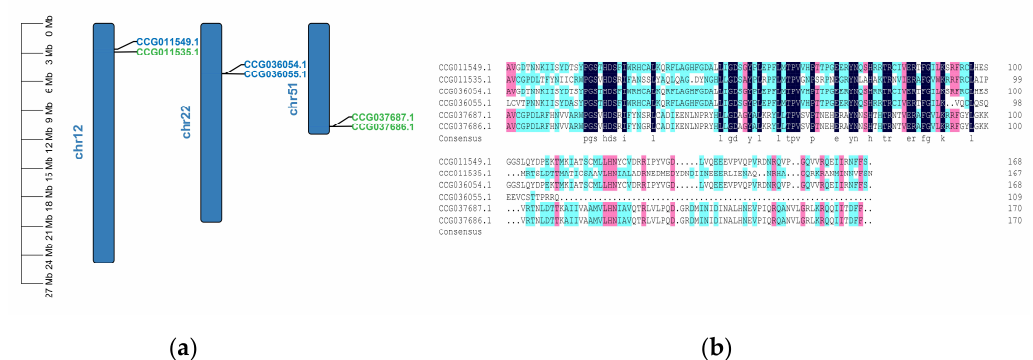
Figure 5. Tightly linked DDE_Tnp_4 family genes in E. sinensis . ( a ) Distribution of these genes identified in E. sinensis chromosomes. Subfamily II and III genes were distinguished by green and blue, respectively. ( b ) Multiple alignments of protein sequences. The dark blue shading indicates identical amino acid residues. Pink shading indicates less conserved residues. Light blue shading indicates somewhat similar residues.